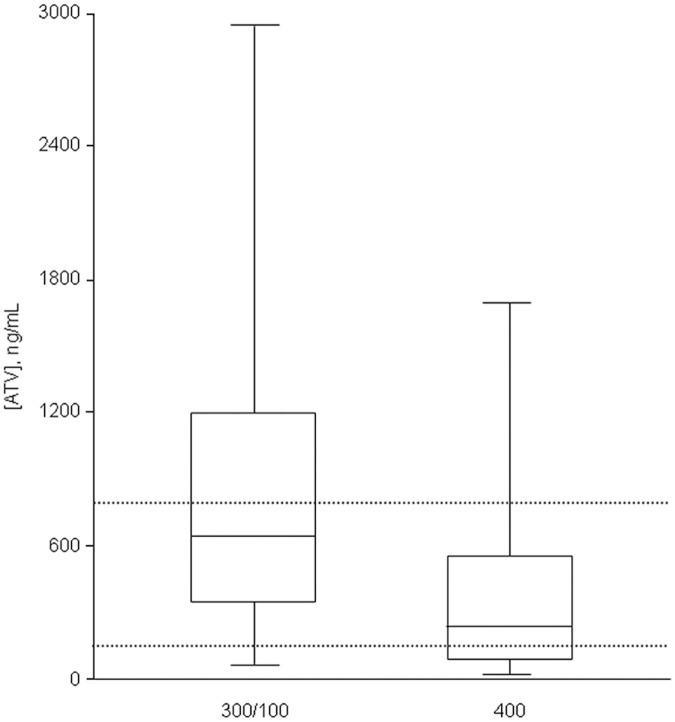
Box-plot of atazanavir (ATV) plasma trough concentrations clustered according to drug dosage.Dashed lines represent the upper and lower limits of the therapeutic window of ATV concentrations (150–800 ng/mL).